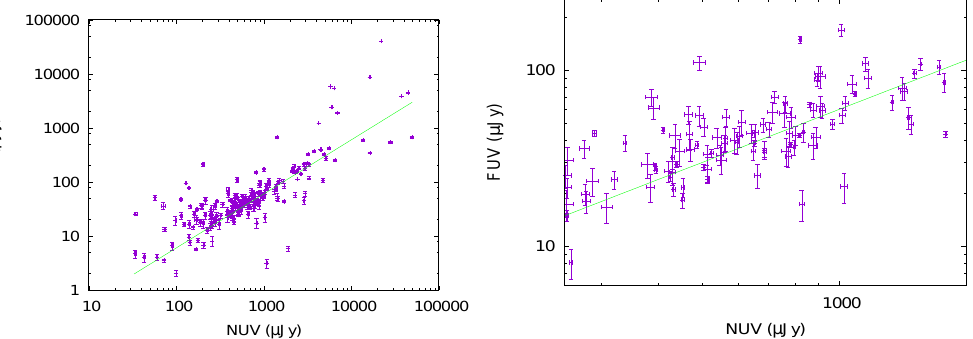
Figure 5. ( Left ) The mean FUV- and NUV-band fluxes of AGB stars observed with GALEX, for sources that were detected in both UV bands with a signal-to-noise ratio, SNR ≥ 5. The green line shows a linear least-squares fit with outlier rejection, f FUV = R FUV / NUV ∗ f NUV , with R FUV / NUV = 0.06 ± 0.002. ( Right ) An expanded view of the central region is shown in the plot on the ( Left